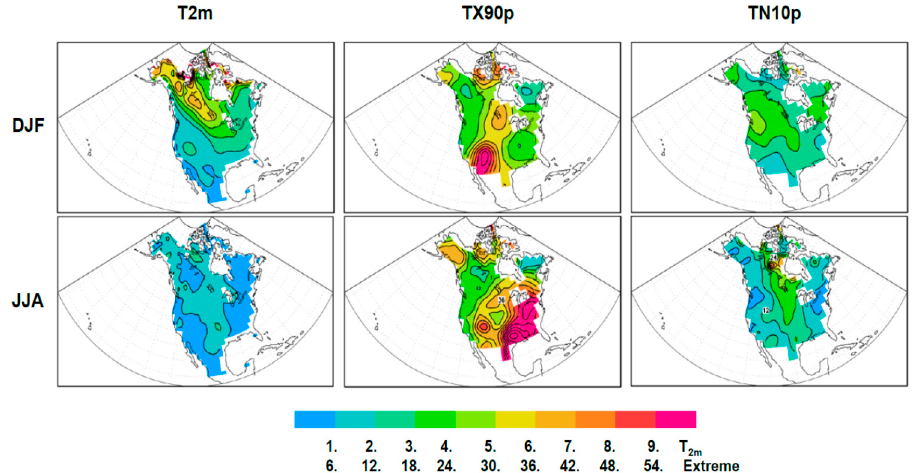
Figure 1. Interannual variances of North American surface temperature (T 2m , left column), warm days (TX90p, middle column), and cold nights (TN10p, right column) in December–January–February (DJF, top row) and June–July–August (JJA, bottom row). Contour intervals are 1.0 °C 2 for T 2m and 6.0% 2 for temperature extremes.